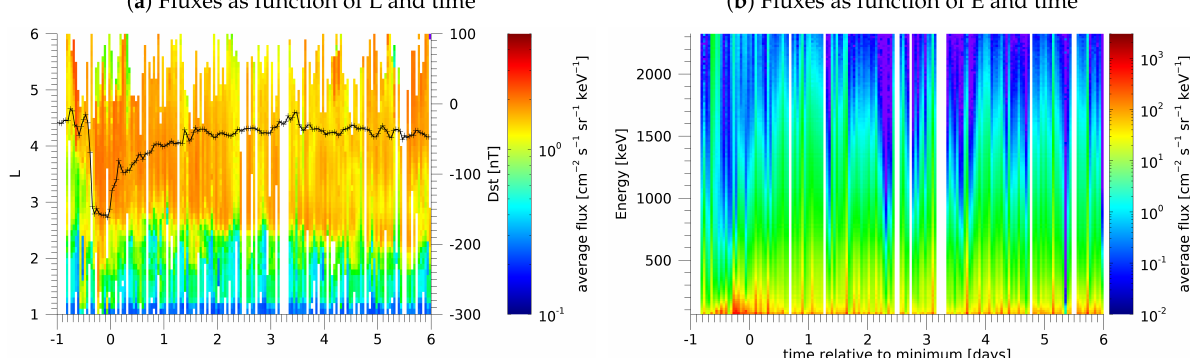
Figure 7. Dependences obtained for the fifth storm that fits neither Type 1 nor Type 2 classification. ( a ) Energetic particle fluxes color-coded as a function of L-shell (ordinate) and time from the Dst minimum (abscissa). The Dst index is overplotted by the thick black curve. ( b ) Average energetic particle fluxes at L-shells between 1 and 6 color-coded as a function of energy (ordinate) and time relative to the Dst minimum